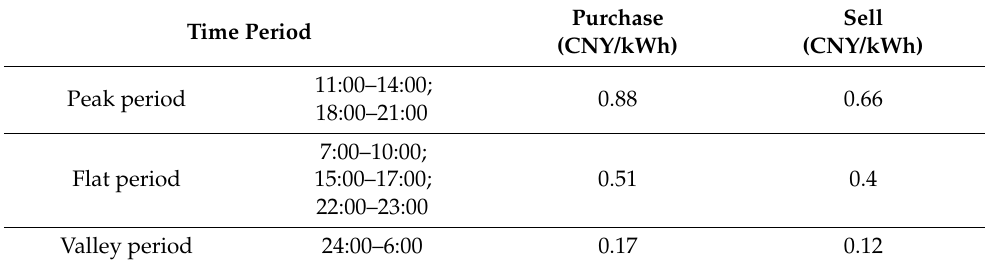
Table 2. Pollutant emission parameters of micro gas turbine [35,46].